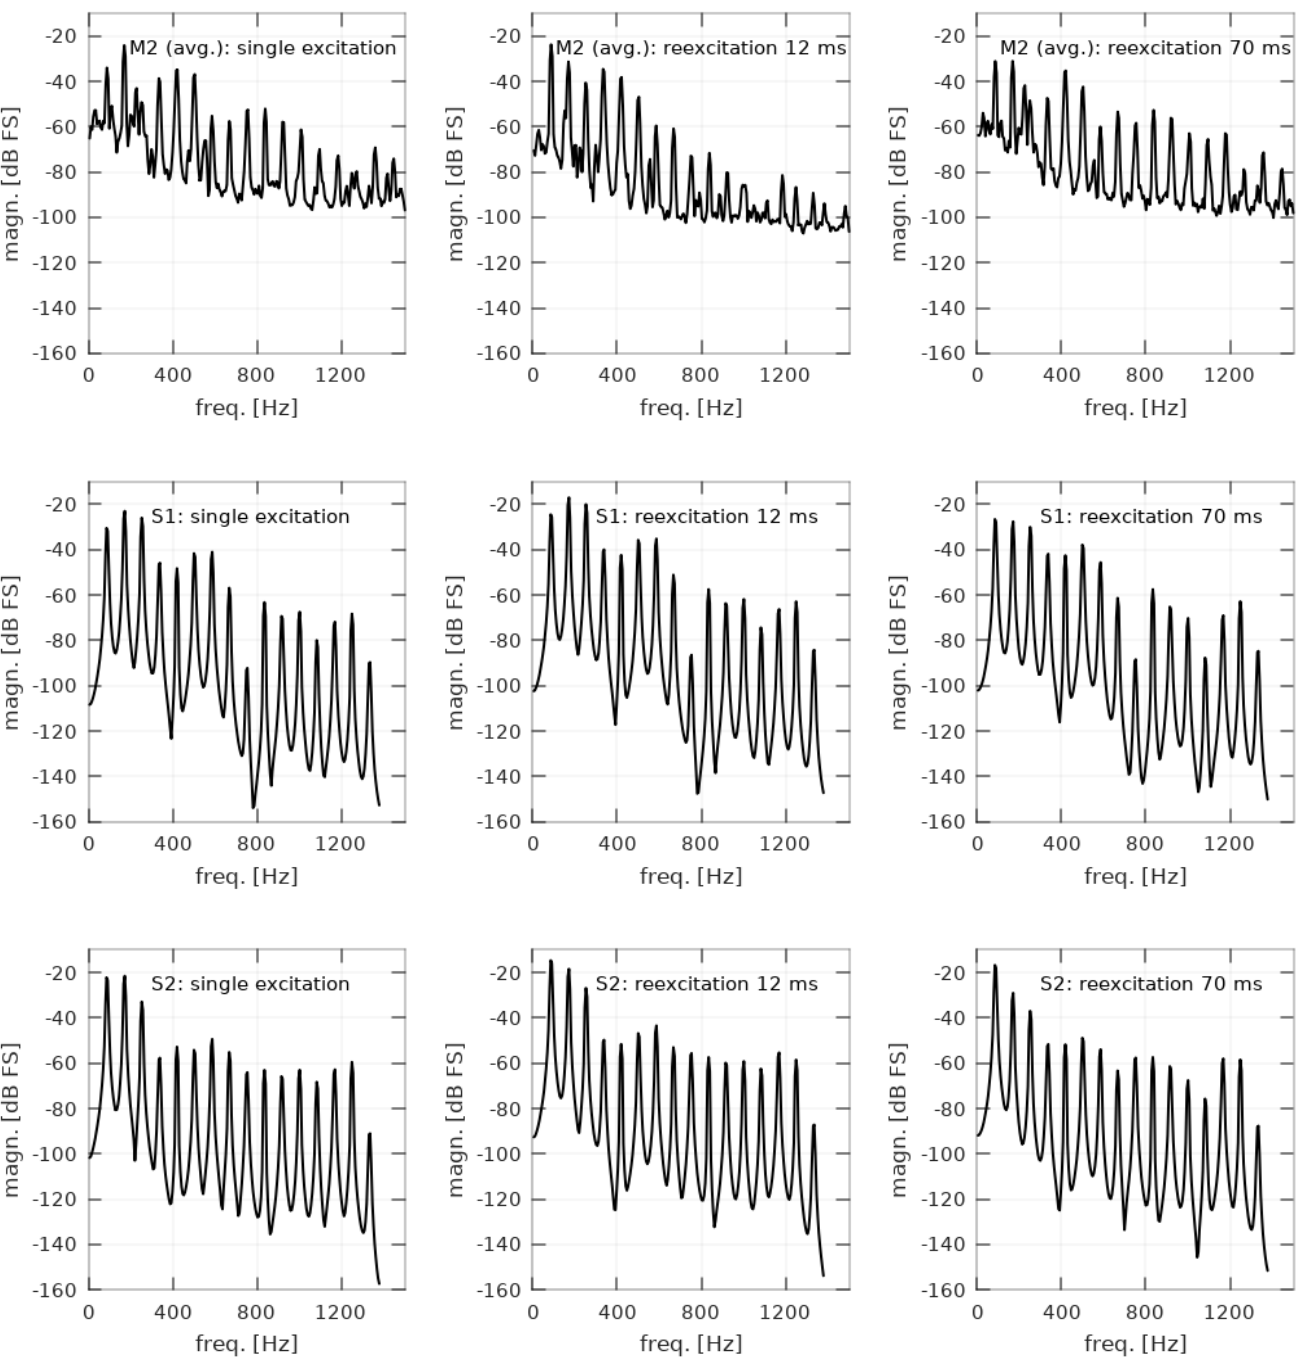
Figure 10. Comparison of spectra of single pluck and of short re-excitation (12 ms and 70 ms delay) for robot measurements (averaged over 10 cases) and for both